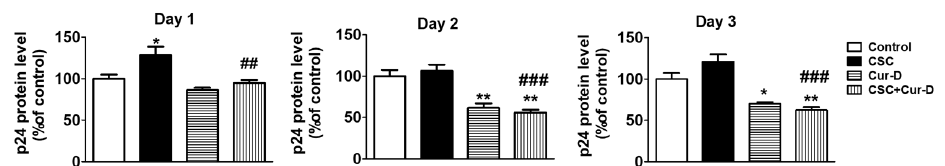
Figure 8. Effect of CSC and Cur-D on the viral load after crossing the in vitro BBB model: To determine the efficacy of Cur-D on CSC-induced viral replication, we used differentiated U1 cells to create a modified in vitro BBB model in a Transwell ® plate, as described in the methodology. The upper inserts containing endothelial cells were exposed to a single dose of Control (DMSO), CSC (40 µg/mL), and Cur-D (0.4 µM) and observed for 3 days. HIV-1 viral loads from differentiated U1 cells were measured every day, using a p24 ELISA kit from the culture media of the bottom chamber. One-way ANOVA with Tukey’s post-hoc test was applied to compare between multiple groups. * and ** represent p < 0.05 and p ≤ 0.01, respectively, when compared to control. ## and ### represent p ≤ 0.01 and p ≤ 0.001, respectively when compared to CSC.